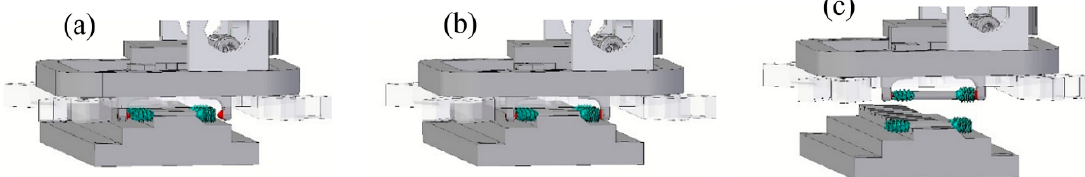
Figure 14. Screw gripping process from the tray unit ( a ) approaching; ( b ) holding and ( c ) moving to feed the overmolding tool.